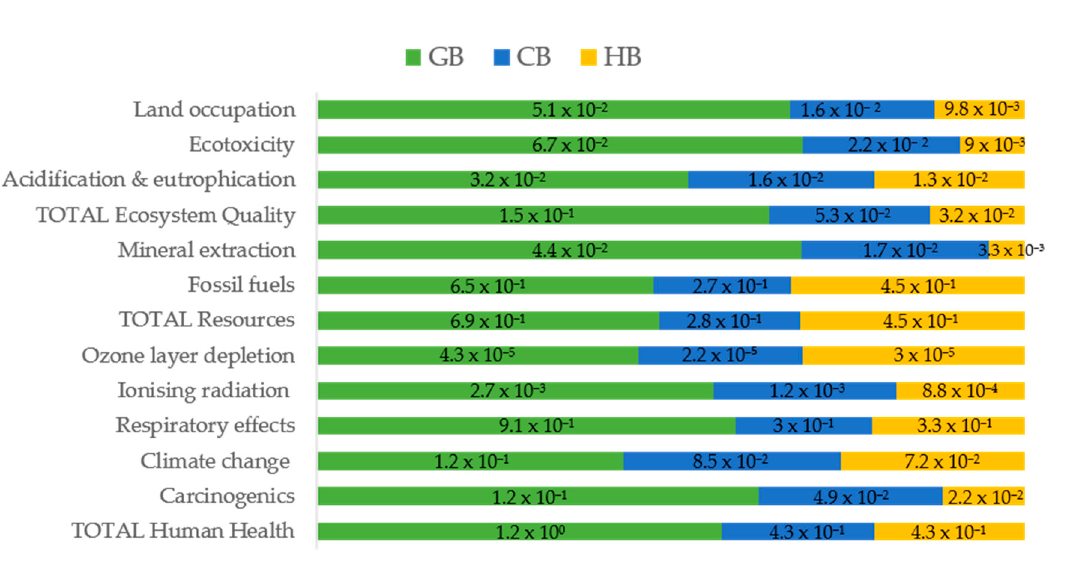
Figure 3. Resume of main Eco-indicators for each